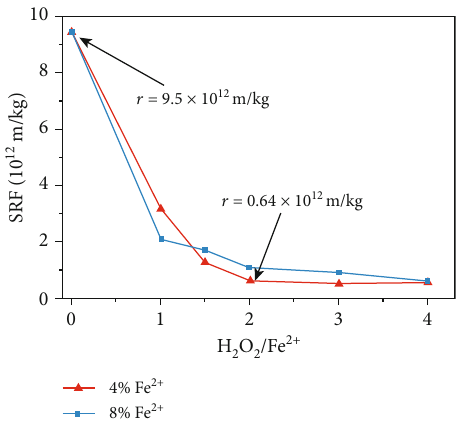
Figure 7: Relationship curve between the speci fi c resistance and mixture ratio of the